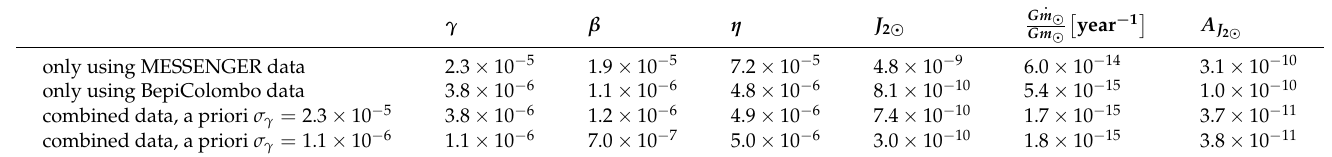
Table 4. Formal uncertainties (1 σ ) of estimated gravity parameters and solar oblateness when using the method described in Section 2. For the solar spherical harmonics, the time-variable J 2 (cid:12) is implemented in the virtual reality and the estimation as dictated by the amplitude A J are performed for various types of inputs, as indicated in the first column.